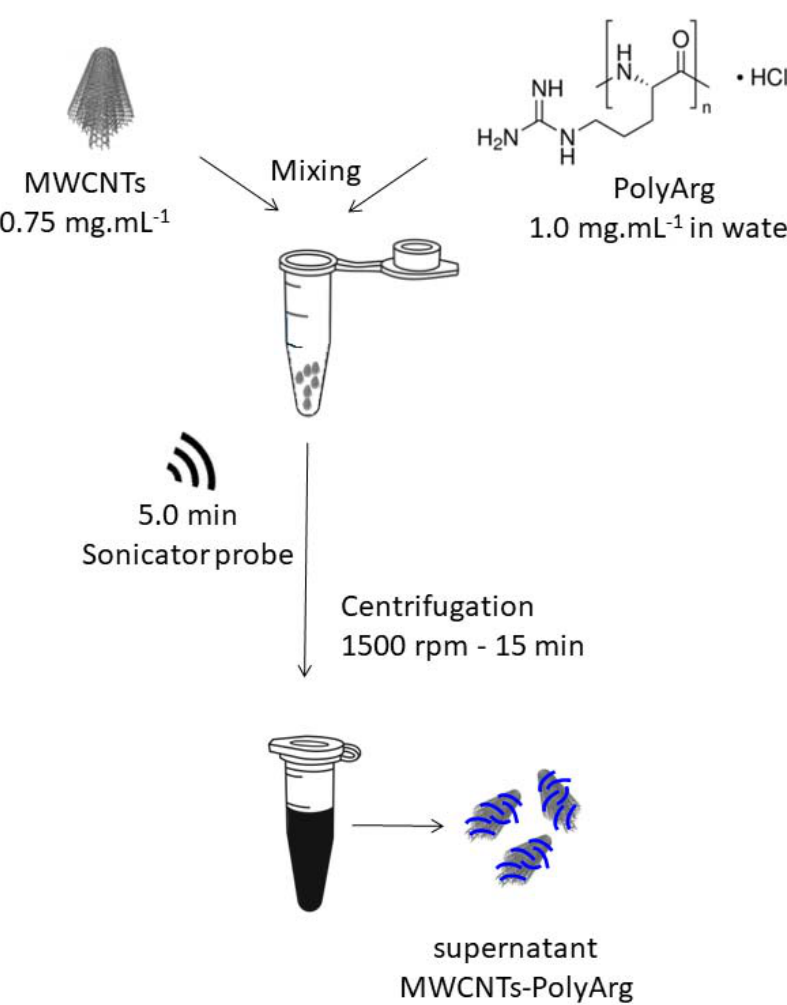
Figure 1. Schematic representation of the MWCNTs’ functionalization with PolyArg.